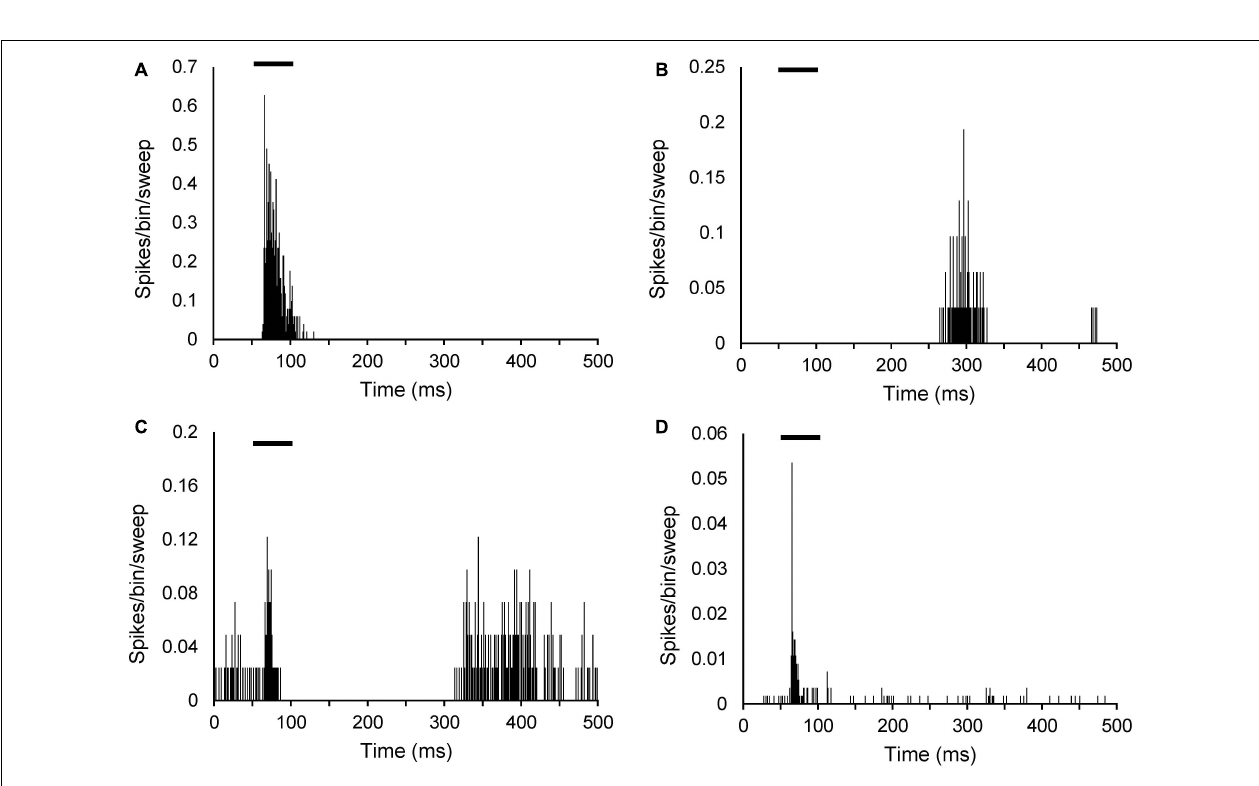
FIGURE 3 | Peristimulus time histograms (PSTHs) illustrating different sound evoked response types in MGN neurons. PSTHs show single neuron responses to a 50-ms pure tone at CF 20 dB above threshold. Spikes are shown as per bin width (bin width of 1 ms) per sweep (50 sweeps). (A) Onset neuron (CF: 6.5 kHz; threshold 43 dB SPL). (B) Off response neuron (CF: 619 Hz; threshold 66 dB SPL). (C) On and off response neuron (CF 16.3 kHz; threshold 77 dB SPL). (D) Sustained response neuron (CF 15.6 kHz; threshold 41 dB SPL). Black bars in each panel indicate timing and duration of the tone burst.